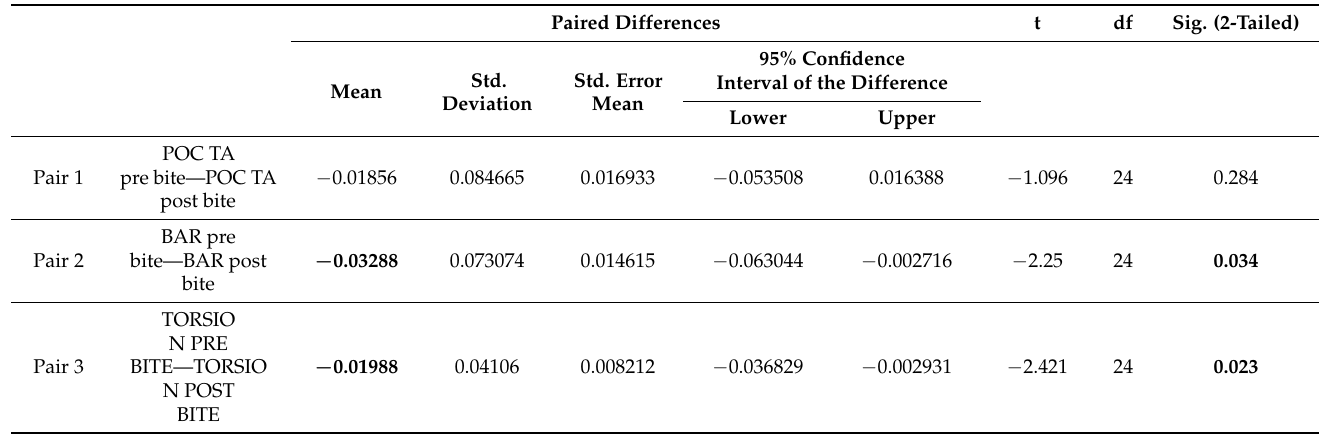
Table 3. Statistical analysis of the differences of mean values at t0 and t1. Statistically significant values are highlighted in bold type. Statistical significance is evident in the difference in the values of: -TOR PRE (0.860 ± 0.124) and POST (0.880 ± 0.114; p = 0.023); -BAR PRE (0.822 ± 0.134) and POST (0.855 ± 0.150; p = 0.034). Paired Differences t df Sig. (2-Tailed) 95% Confidence Std. Std. Error Interval of the Difference Mean Deviation Mean Lower